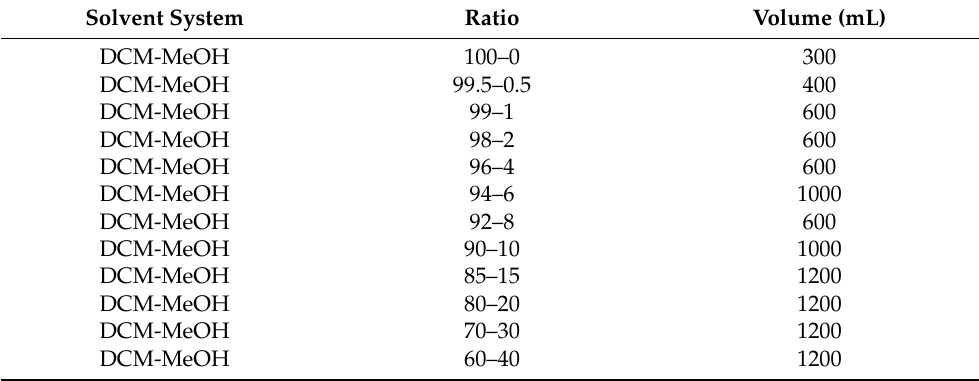
Table 5. Solvent system used for the fractionation of the MeOH extract of Terminalia leiocarpa